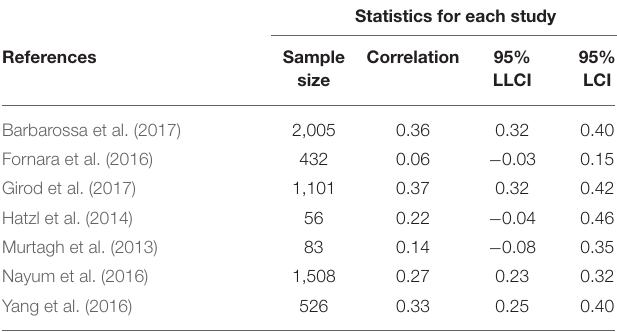
TABLE 3 | Summary of ES of the association between values and energy saving behaviors (or intentions).